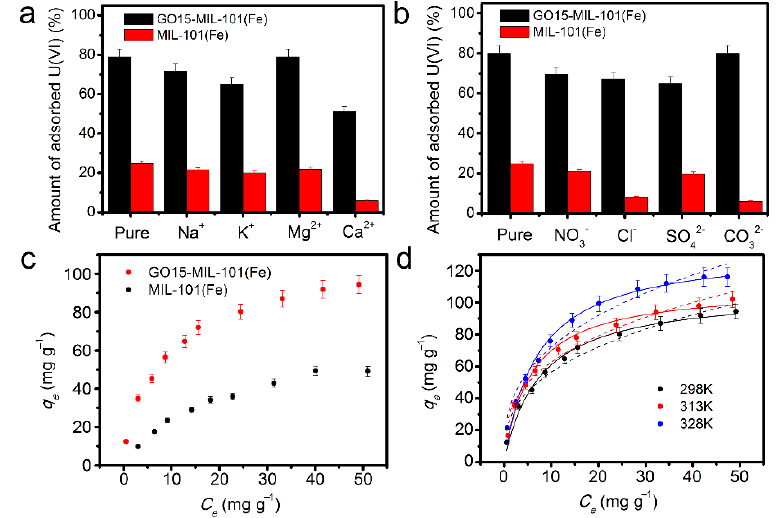
Figure 5. The effect of different ( a ) cation ions and ( b ) anion ions on the amount of adsorbed U (VI) on MIL-101(Fe) and GO15h-MIL-101(Fe) composites ( C 0 = 10 mg L − 1 , pH = 5.5, T = 298 K, m / V = 0.2 g L − 1 , and I NaNO = 0.01 M), ( c ) comparison of adsorption isotherms of MIL-101(Fe) and GO15-MIL-101(Fe) composites, and ( d ) adsorption isotherms of GO15-MIL-101(Fe) composite under different temperature (T = 298 K, 313 K, 328 K, pH = 5.5, m / V = 0.2 g L − 1 , and I NaNO = 0.01 M). The solid and dashed lines represent the Langmuir model and Freundlich model, respectively.